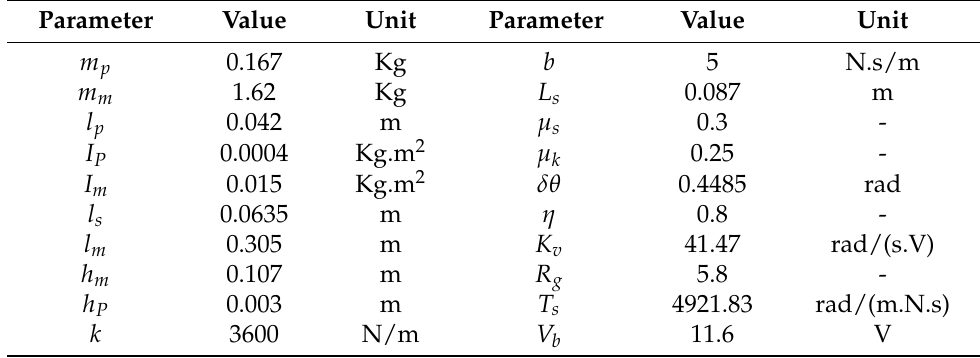
Table A2. Tapping Robot